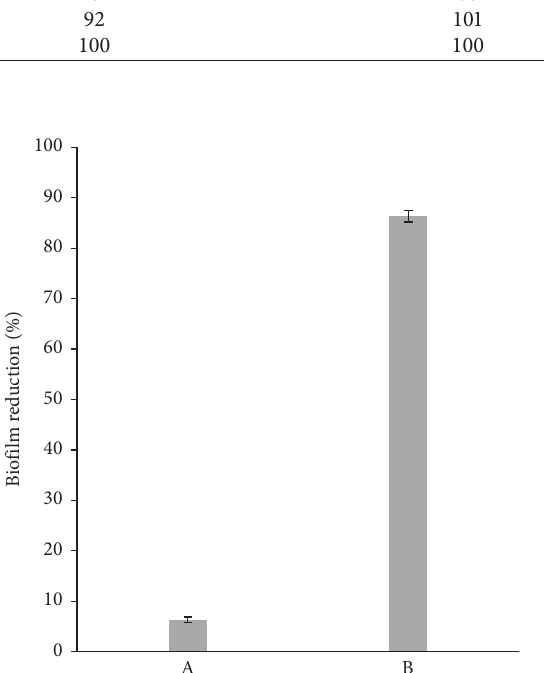
Figure 10: The effect of purified dextranase enzyme on biofilm formation of P . aeruginosa standard strain PAO1. (A) The dextranase- inhibitory effect on biofilm formation during bacterial cultivation. (B) The dextranase-reducing effect on 24h old-established